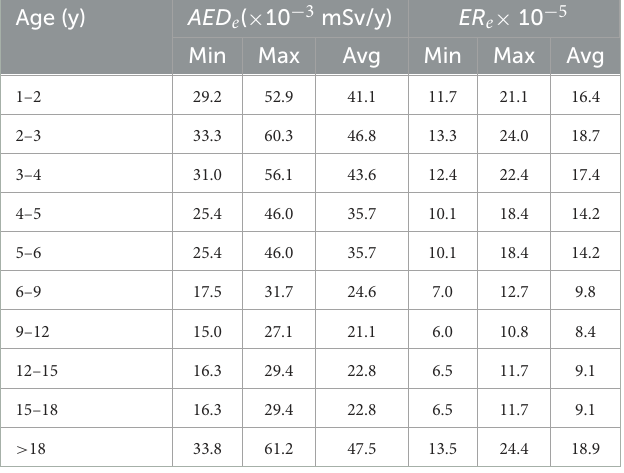
TABLE 9 Age-dependent AED e and ER e induced by the exposure of ambient environment for the population around SNPP from 2014 to 2021. Age (y) AED e ( × 10 − 3